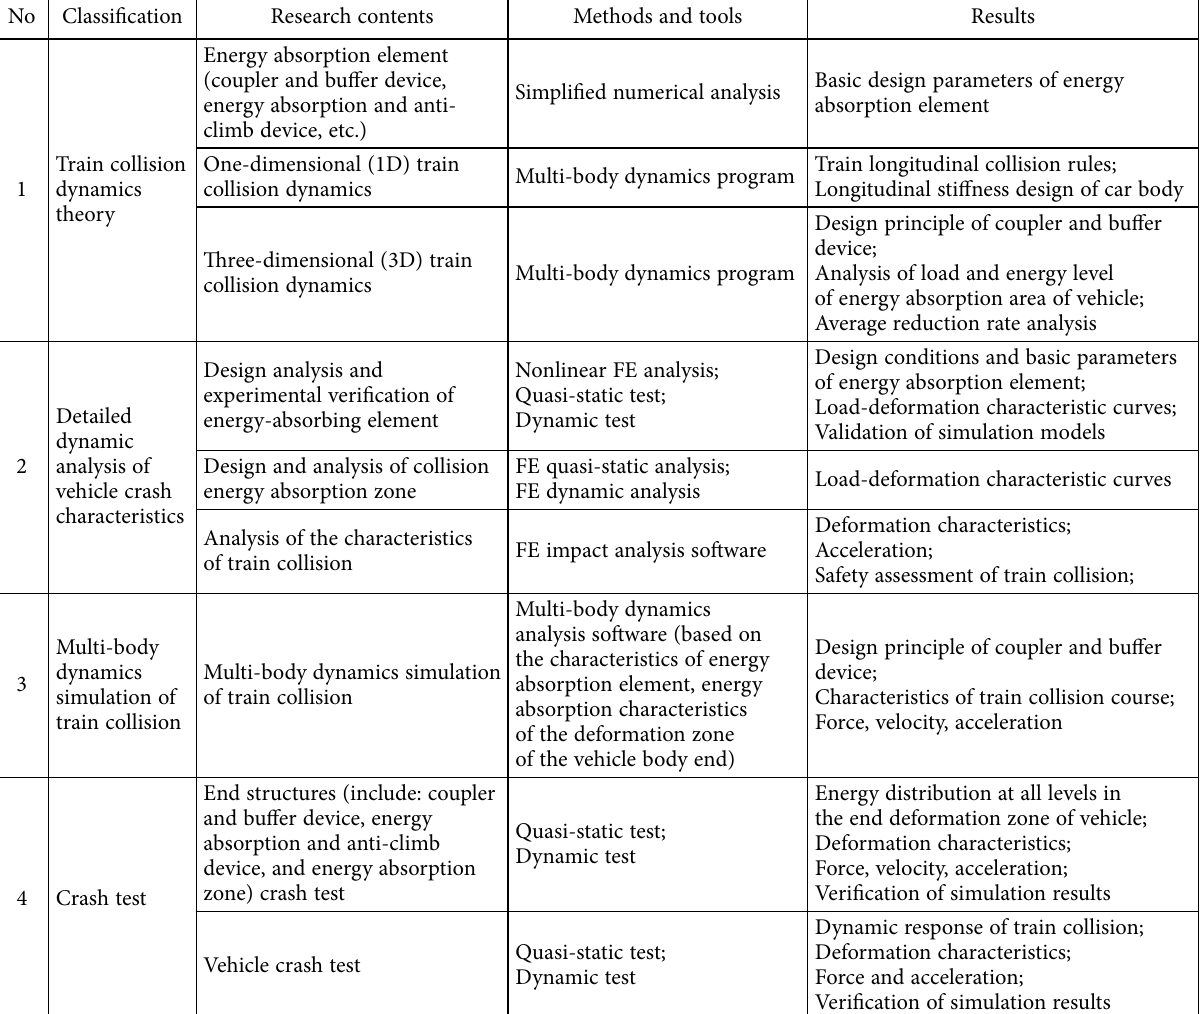
Table 1. Collision safety methods of rail vehicle car